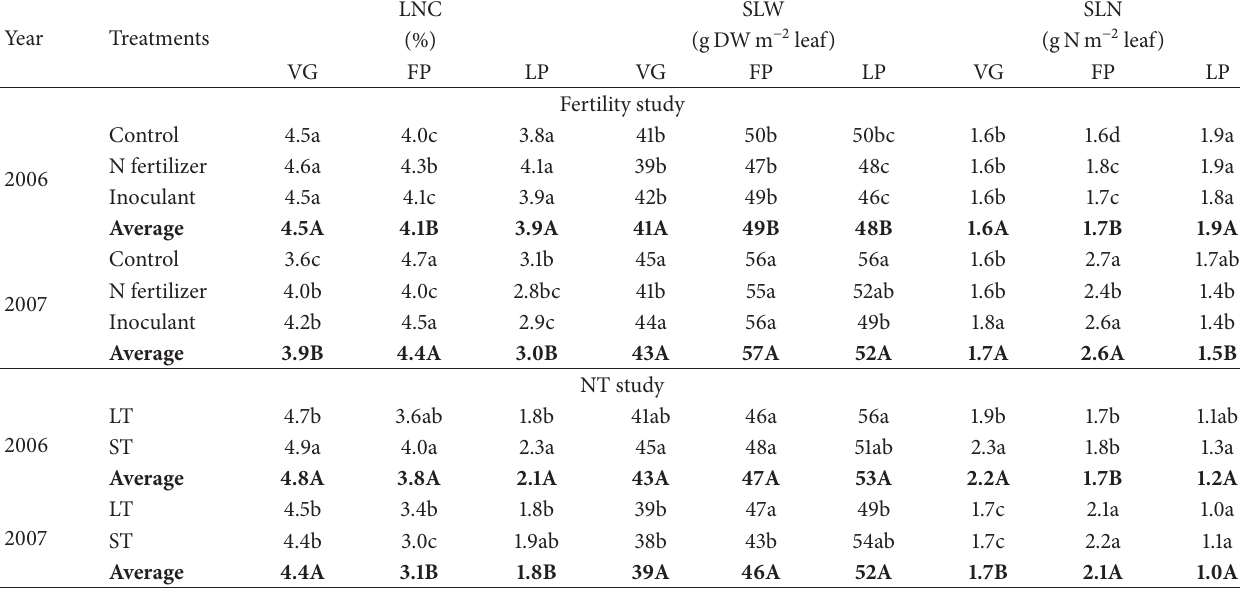
Table 1: Average leaf N concentration (LNC), specific leaf N (SLN), and specific leaf weight (SLW) of lentil at three growth stages of vegetative growth (VG), first-pod (FP), and late-pod (LP) under three N fertility treatments (top) and two NT duration treatments (bottom) in 2006 and 2007.